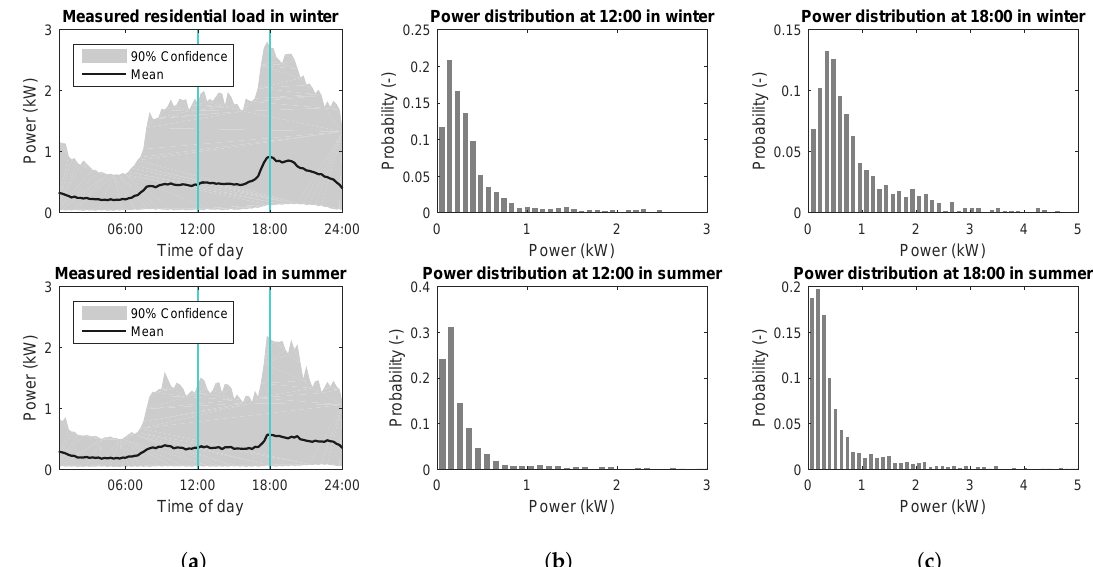
Figure 2. Load behavior in winter and summer. ( a ) Mean profiles and 90% confidence interval around the mean. ( b , c ) Stochastic behavior of load at specific time intervals.